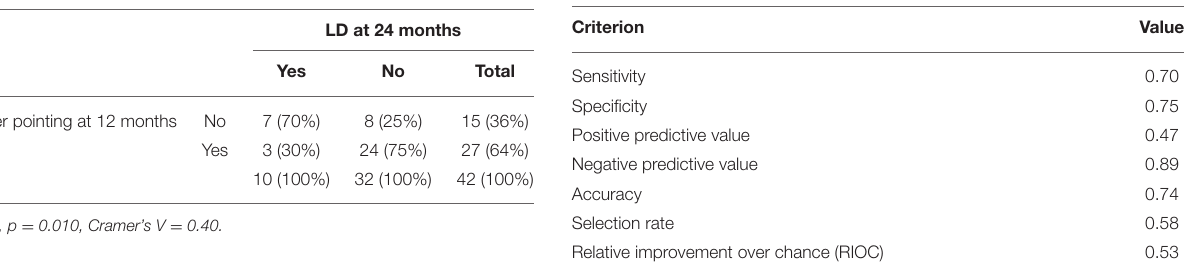
TABLE 3 | Classification of children as being language delayed at 24 months based on their ability to produce index-finger points at 12 months.